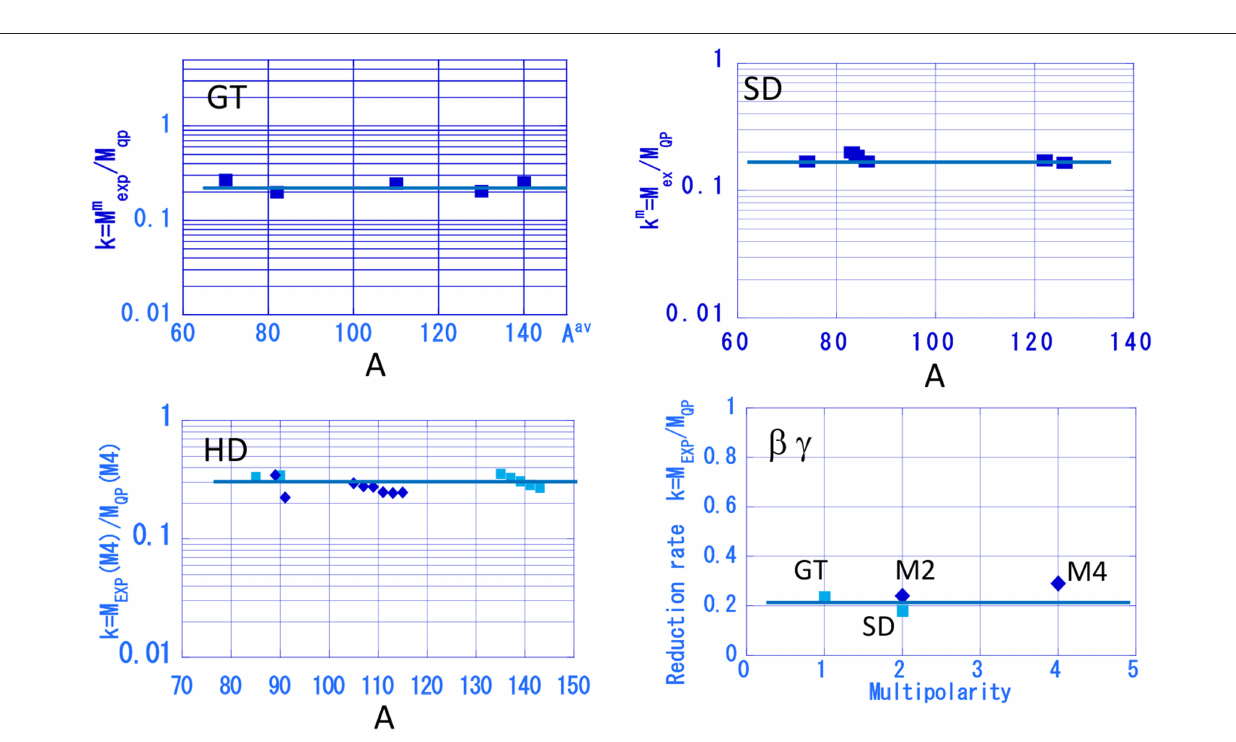
FIGURE 5 | The reduction coefficients for single GT, SD, and HD NMEs with respect to the QP NMEs are plotted against the mass number A in panels GT, SD, and HD. The average reduction coefficients for β and γ decays are given against the multipolarity in panel βγ